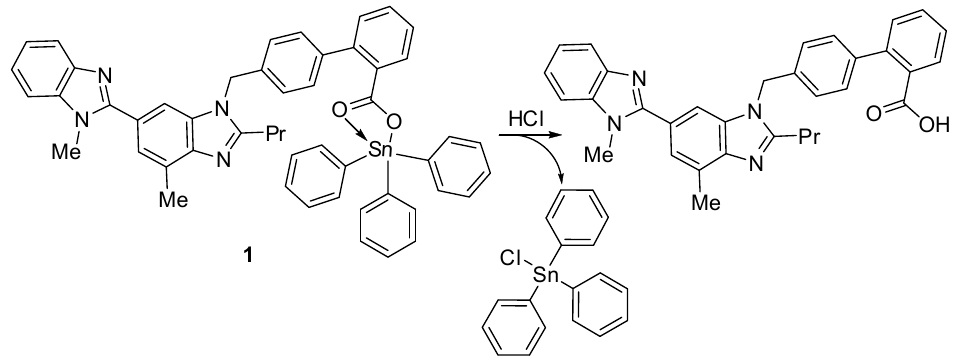
Figure 14. Organotin 1 acts as a hydrogen chloride scavenger.